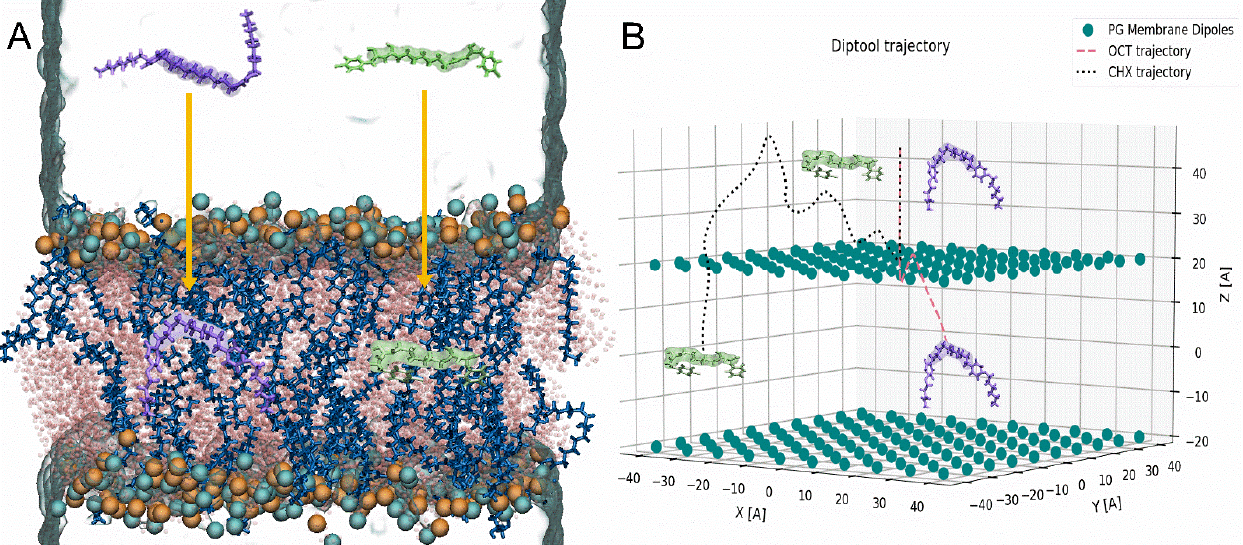
Figure 2. Initial and final trajectories obtained from ( A ) ABF − method, ( B ) Diptool software on PG membranes. CHX: green sticks and surface, OCT: violet sticks and surface, POPG: blue and pink sticks, phosphorous atoms: cyan beads, nitrogen atoms: orange beads and PG membrane dipoles: teal beads.